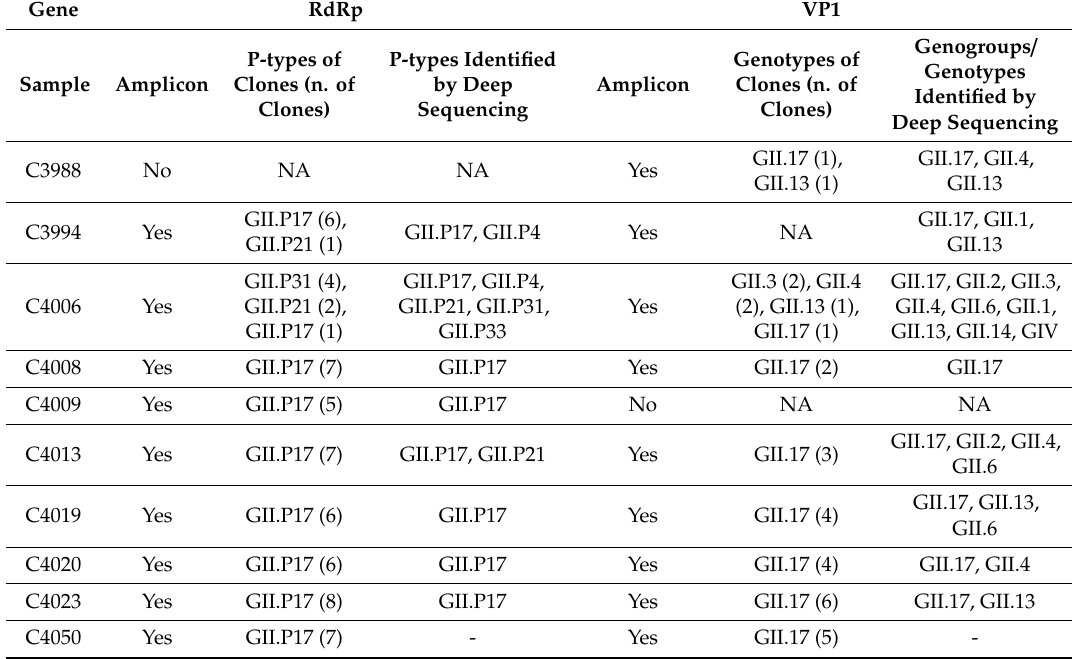
Table 4. NoV genogroups, genotypes, and P-types detected using cloning and deep-sequencing approaches on shellfish